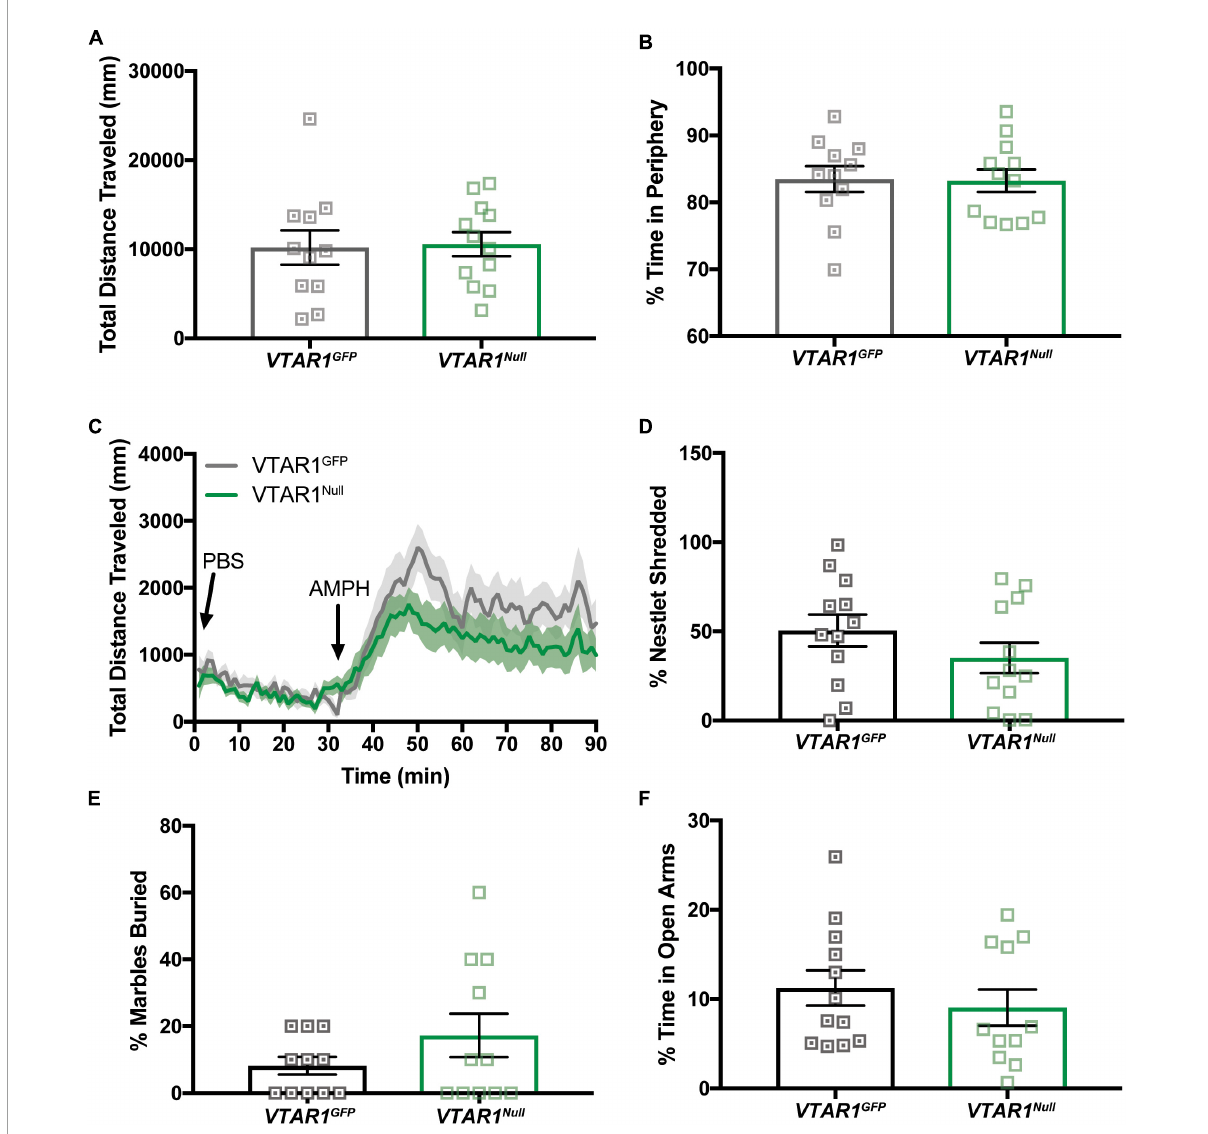
FIGURE8 Specific VTA NtsR1 deletion does not alter DA-dependent locomotor activity or anxiety behaviors. VTAR1 GFP and VTAR1 Null mice were placed in open field boxes and videotracked to assess exploratory behavior and locomotor activity. In panels (A,B) , mice were left to explore box for 30mins, bars represent last 15 min of data collected and analyzed. In panel (C) , mice were left to explore the box for 30 min after PBS injection, and for 30 min after amphetamine (AMPH) treatment. (A) Total distance traveled under baseline condition (no injection). (B) % time spent in box periphery under baseline condition. (C) Total distance traveled before, during and after PBS and AMPH treatment. VTAR1 Null mice did not have a significantly prolonged response to AMPH compared to VTAR1 GFP mice. To assess whether VTAR1 Null mice engaged in anxiety-like behaviors, they were given a nestlet to shred and marbles to bury for 30 min and placed in the Elevated Plus Maze (EPM) for 5 min. Deletion of NtsR1 specifically from the VTA in adulthood did not significantly alter (D) % of nestlet shredding, (E) % of marbles buried, or (F) % time spent in